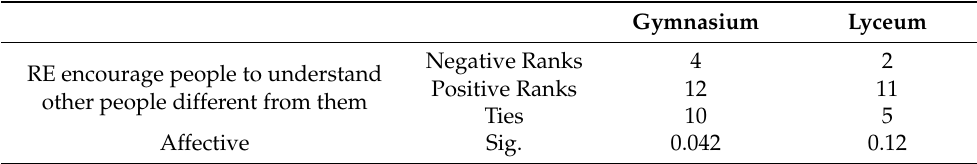
Table 9. Changing students’ attitudes towards RE in relation to encourage people to understand the diversity. Gymnasium Lyceum Negative Ranks 4 2 RE encourage people to understand Positive Ranks 12 11 other people different from them Ties 10 5 Affective Sig. 0.042 0.12